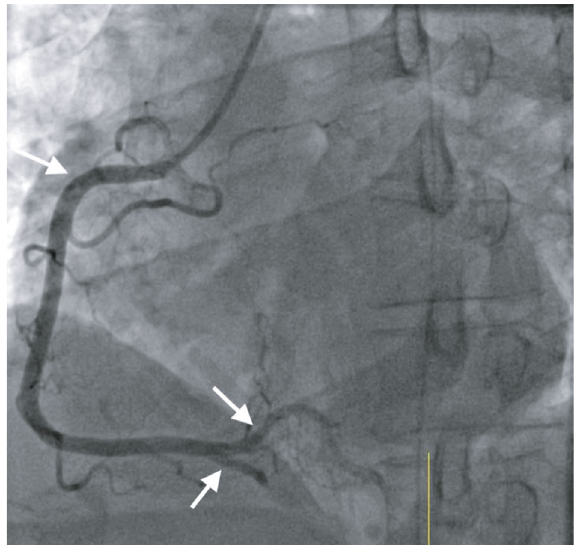
Figure 3: Coronary angiography after intervention. pRCA and rPL s/p aspiration thrombectomy: coronary angiography (LAO view) showing complete resolution of thrombi in the pRCA and rPL branches after aspiration thrombectomy (white arrows). However, the PDA remained occluded with microthrombi as a consequence of intervention in the proximal RCA (white